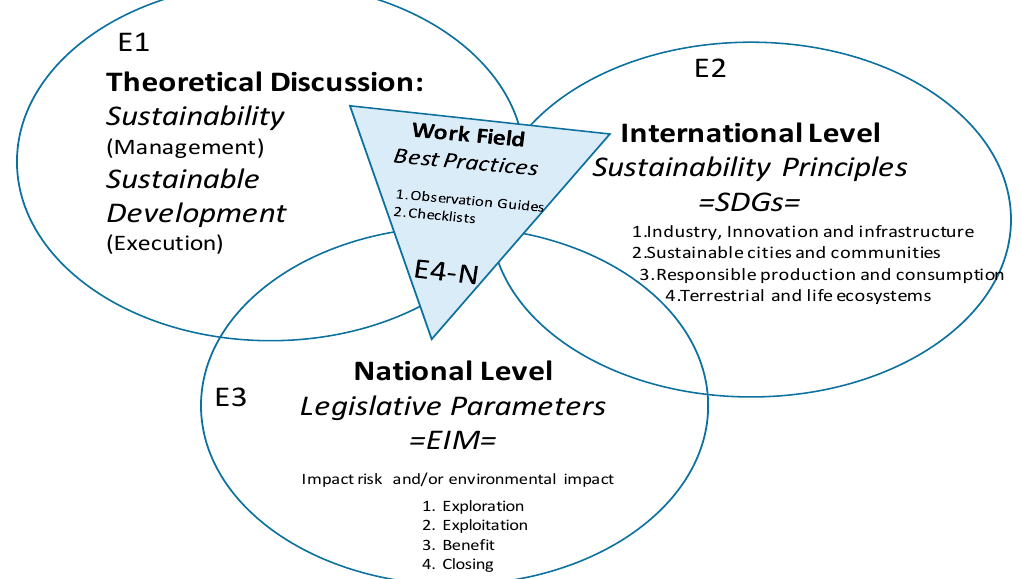
Figure 1. Sustainable Model and its elements for the Mining-metallurgical Industry. Source: own